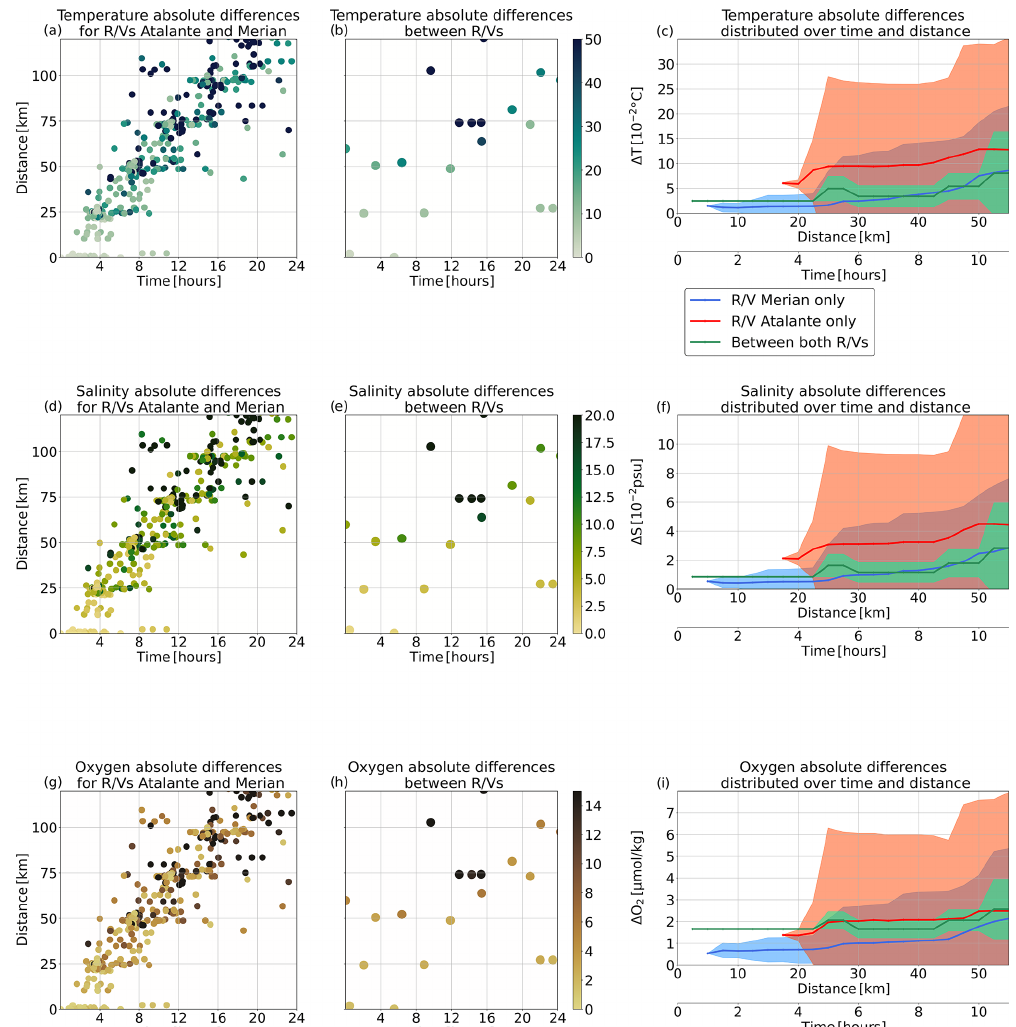
Figure 6. (a) Absolute temperature differences between CTD pairs of profiles on isopycnal levels, averaged and vertically distributed in time and distance. Each CTD pair is only composed of profiles from R/Vs L’Atalante or Maria S. Merian . (b) Same as panel (a) but for CTD pairs composed of one profile from R/V L’Atalante and one from R/V Maria S. Merian . (c) Temperature differences as a function of time and distance for CTD pairs from R/Vs Maria S. Merian (blue), L’Atalante (red), and composed of one profile of each (green). Panels (d) , (e) , and (f) are the same as the above but for absolute salinity differences. Panels (g) , (h) , and (i) are for absolute oxygen